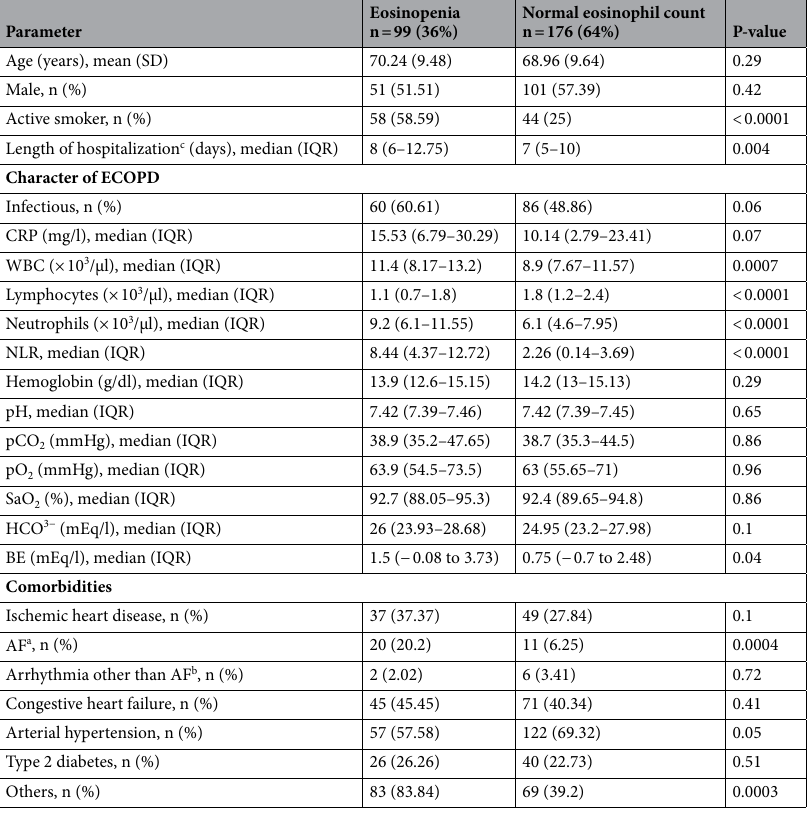
Table 2. Study parameters upon stratification by eosinophil count. AF atrial fibrillation, CRP c-reactive protein, IQR interquartile range, WBC white blood count. a First detected in the admission, paroxysmal, persistent or permanent. b In the admission or in the past medical history. c Among